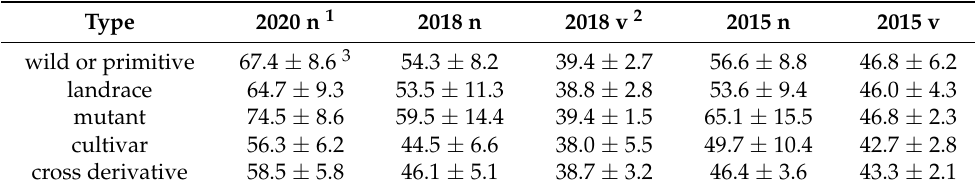
Table 1. Mean number of days from sowing to flowering observed in white lupin germplasm in